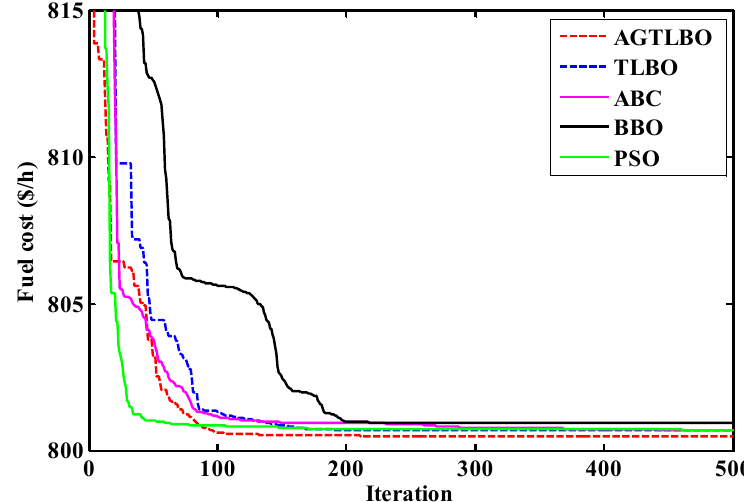
Figure 7. Convergence of algorithms for Case 1.